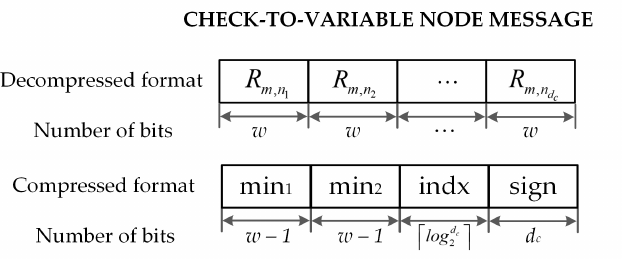
Figure 6. Check-to-variable node message presents in decompressed and compressed